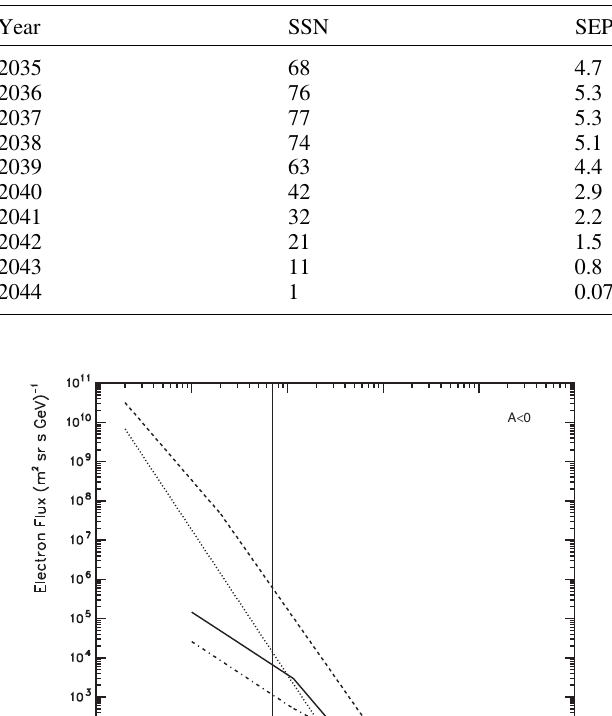
Table 7. Expected Sunspot Number (SSN) and SEP events during the LISA mission with a fl uence larger than the estimated GCR